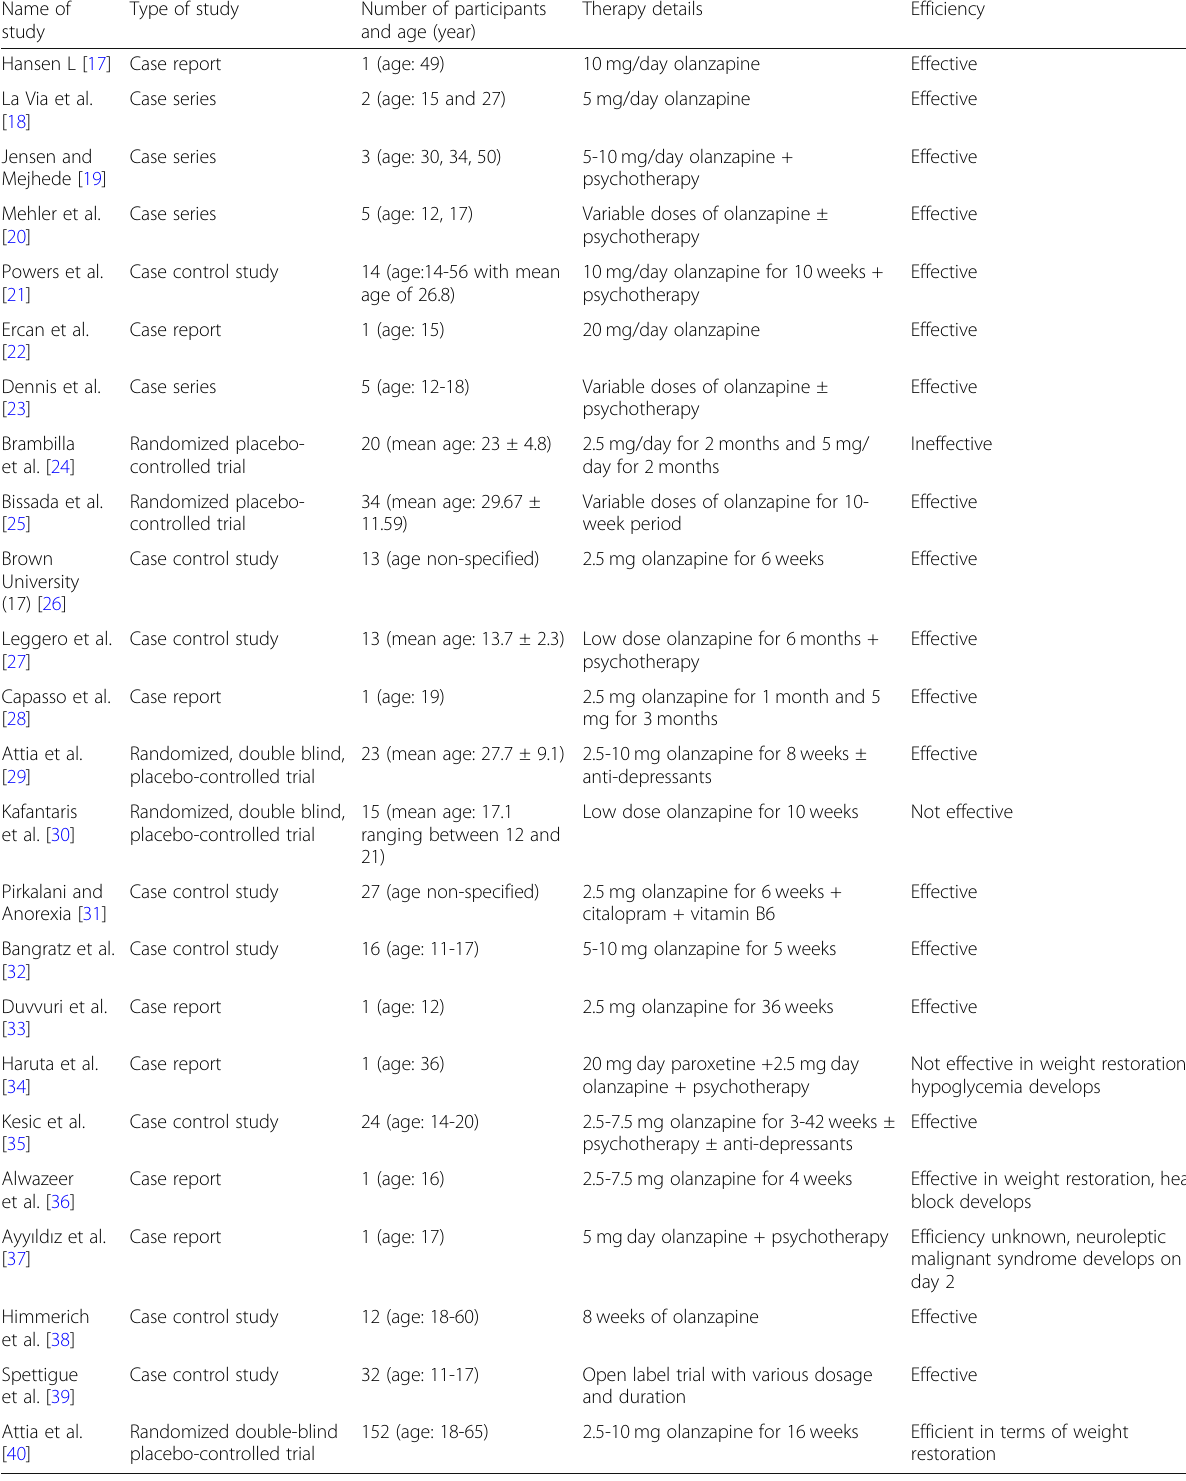
Table 2 General characteristics of the studies used in the systematic